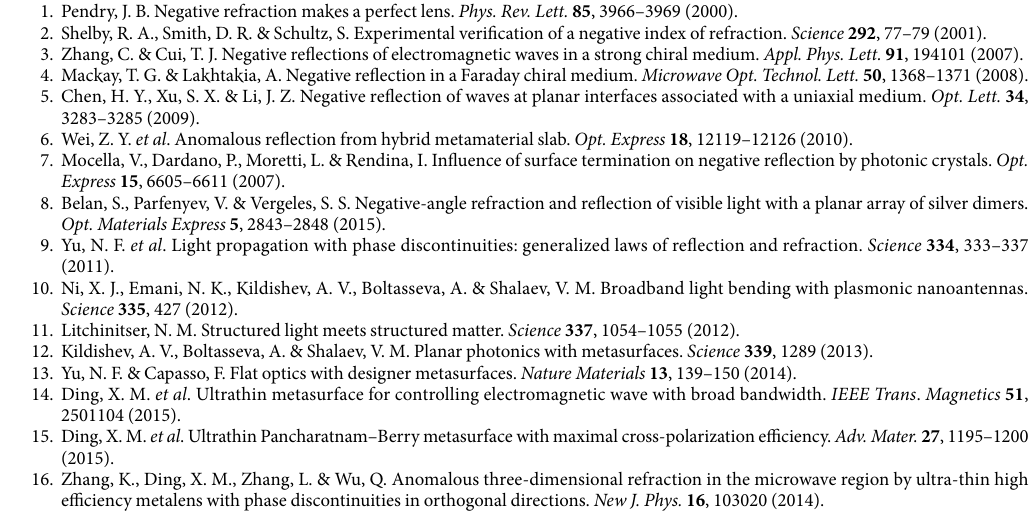
9 Scientific RepoRts | 7: 5729 | DOI:10.1038/s41598-017-06184-1